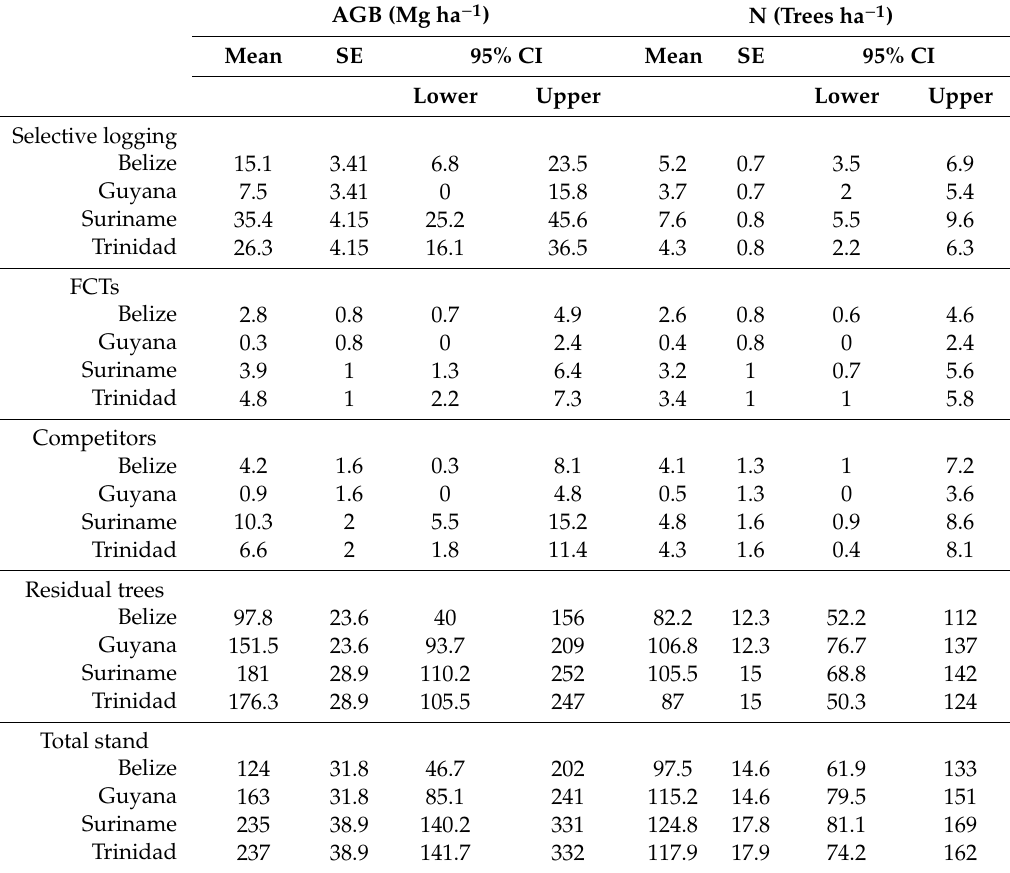
Table 4. Estimates of the above ground biomass (AGB) and number of trees (N) during the application of selective logging and release of future crop trees (FCTs), in four study